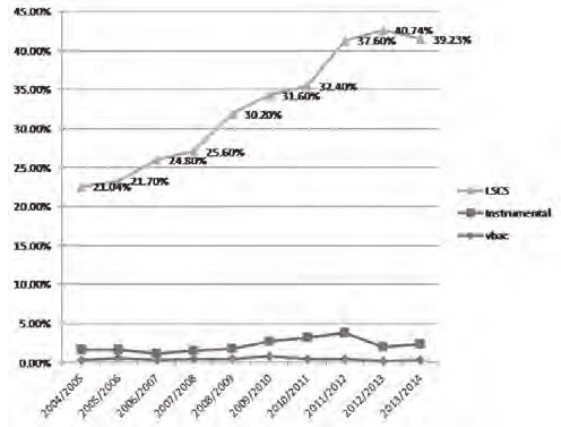
Figure 2: Graphical representation of annual rates of LSCS, instrumental deliveries and VBAC (cid:55)(cid:68)(cid:69)(cid:79)(cid:72)(cid:3)(cid:22)(cid:29)(cid:3)(cid:3)(cid:55)(cid:82)(cid:83)(cid:3)(cid:191)(cid:89)(cid:72)(cid:3)(cid:76)(cid:81)(cid:71)(cid:76)(cid:70)(cid:68)(cid:87)(cid:76)(cid:82)(cid:81)(cid:86)(cid:3)(cid:73)(cid:82)(cid:85)(cid:3)(cid:40)(cid:79)(cid:72)(cid:70)(cid:87)(cid:76)(cid:89)(cid:72)(cid:3)(cid:68)(cid:81)(cid:71)(cid:3)(cid:40)(cid:80)(cid:72)(cid:85)(cid:74)(cid:72)(cid:81)(cid:70)(cid:92)(cid:3)(cid:47)(cid:54)(cid:38)(cid:54)(cid:3)(cid:76)(cid:81)(cid:3)(cid:87)(cid:75)(cid:72)(cid:3)(cid:191)(cid:85)(cid:86)(cid:87)(cid:3)(cid:68)(cid:81)(cid:71)(cid:3)(cid:79)(cid:68)(cid:86)(cid:87)(cid:3)(cid:75)(cid:68)(cid:79)(cid:73)(cid:3)(cid:82)(cid:73)(cid:3)(cid:87)(cid:75)(cid:72)(cid:3)(cid:87)(cid:72)(cid:81)(cid:3)(cid:92)(cid:72)(cid:68)(cid:85)(cid:3)(cid:83)(cid:72)(cid:85)(cid:76)(cid:82)(cid:71) April 13 2004- April 12, 2009 (2061-2065